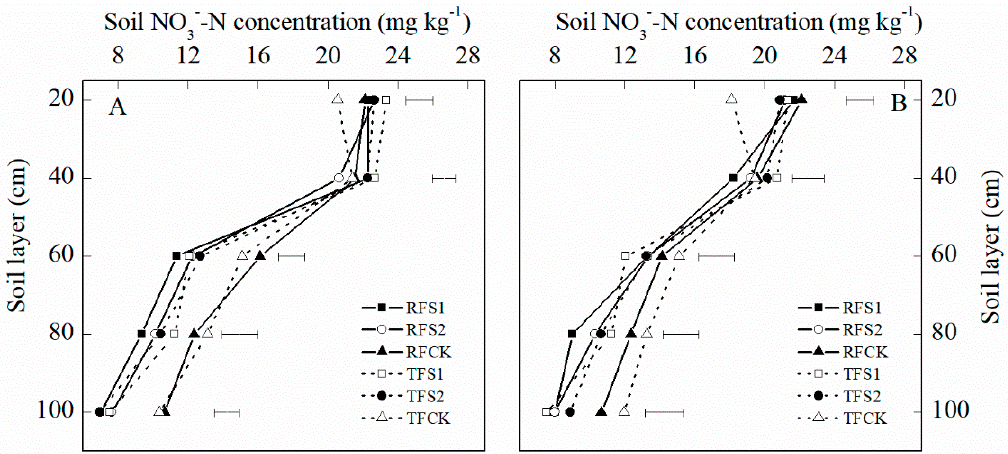
Figure 7. Effects of planting and irrigation on the soil NO 3 − -N concentration in 0–100 cm soil layer in 2016–2017 (A) and 2017–2018 (B), respectively. RF: plastic-covered ridge and furrow planting; TF: